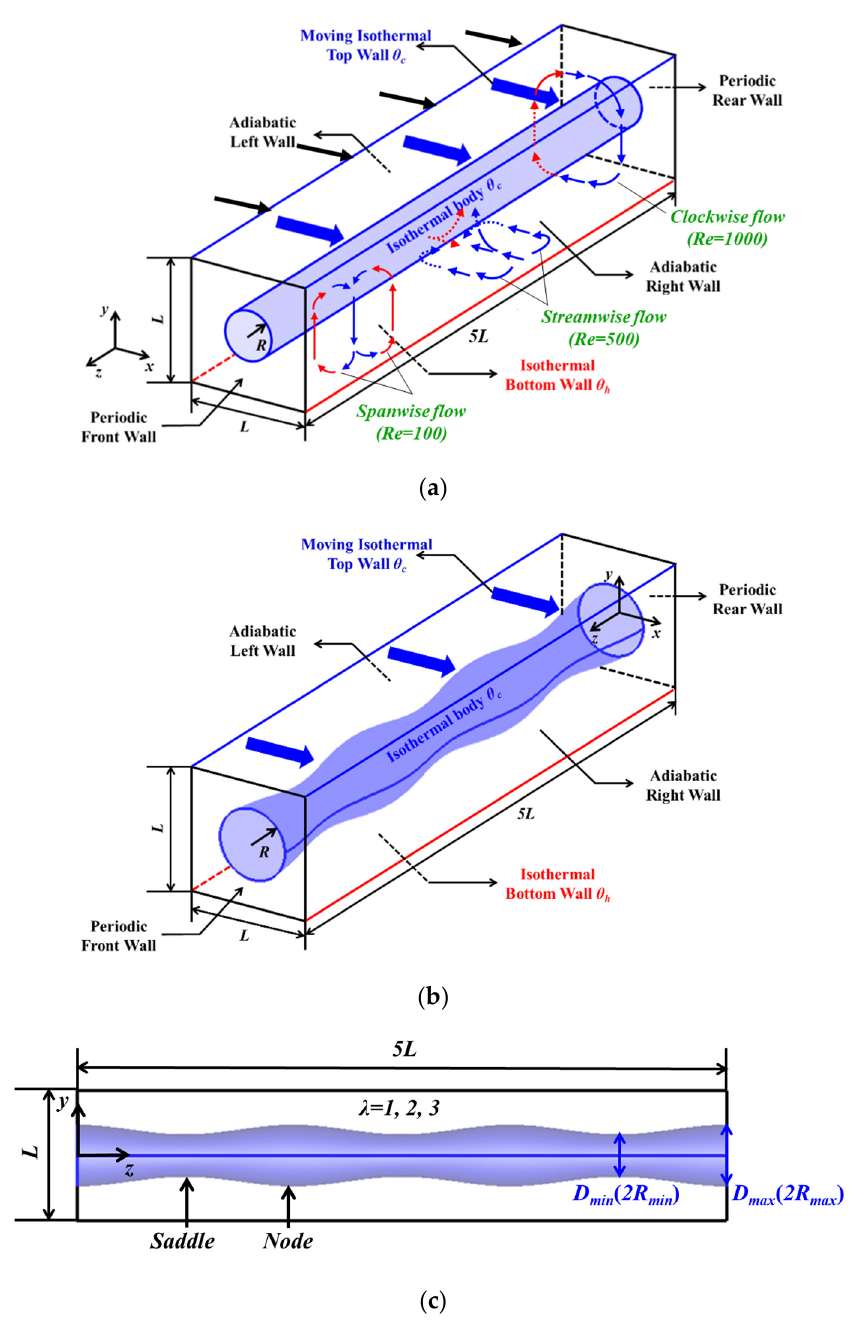
Figure 1. Computational domain, coordinate system, and boundary. ( a ) iso-view of circular cylinder; ( b ) iso-view of sinusoidal circular cylinde; ( c ) side view of sinusoidal circular cylinder. The wavelengths ( λ ) of the cylinder were L z / λ = 5 L ( λ = 1 ) , 2.5 L ( λ = 2 ) , and 1.667 L ( λ = 3 ) in the spanwise direction. The amplitude of the curve surface δ was defined as δ = 0.091 ( R max + R min ) . Consequently, R max and R min were defined as R max = R mean + δ and R min = R mean − δ for the sinusoidal cylinder. Non-dimensional temperatures were imposed on the cold top wall ( θ c = 0), the hot bottom wall ( θ h = 1), and the cold surfaces ( θ c = 0) of the isothermal cylinder. The side walls of the enclosure were adiabatic. The periodic boundary conditions were applied in the spanwise direction ( z ). The top wall moved to the right with a constant velocity ( u = 1). No-slip and impermeability conditions were used for all walls except the top